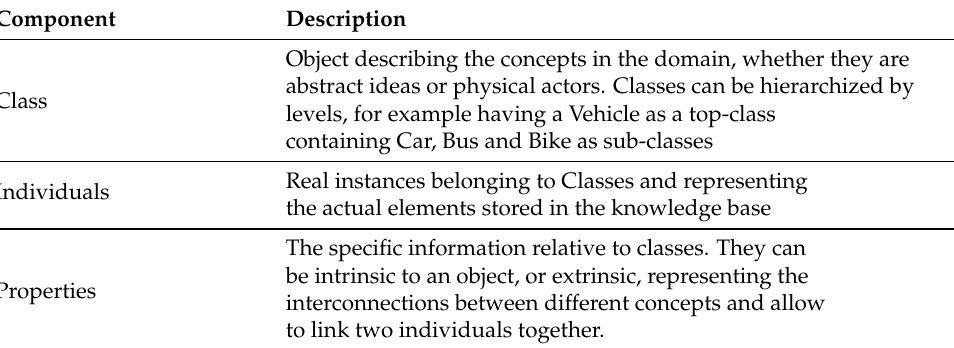
Table 1. Main components of an